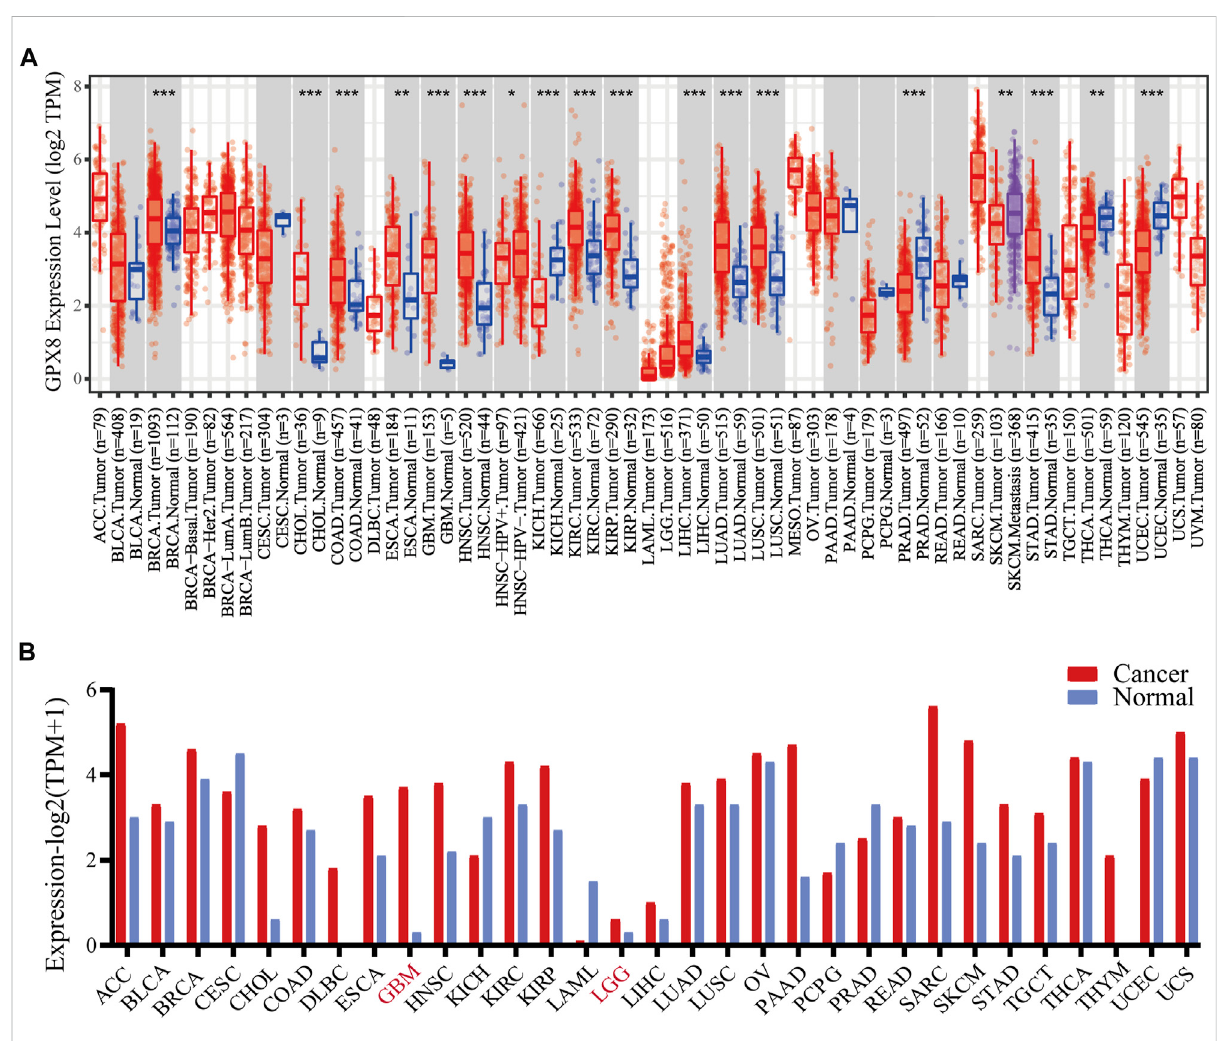
FIGURE 1 mRNAexpressionofGPX8invariouscancersaccessingTIMERandGEPIAdatabases. (A) mRNAexpressionofGPX8incancersandhomologous normal tissues from the TIMER2.0 database. (B) mRNA expression data of GPX8 about cancers and homologous normal tissues were obtained from the GEPIA database.* p < 0.05, ** p < 0.01, and *** p <